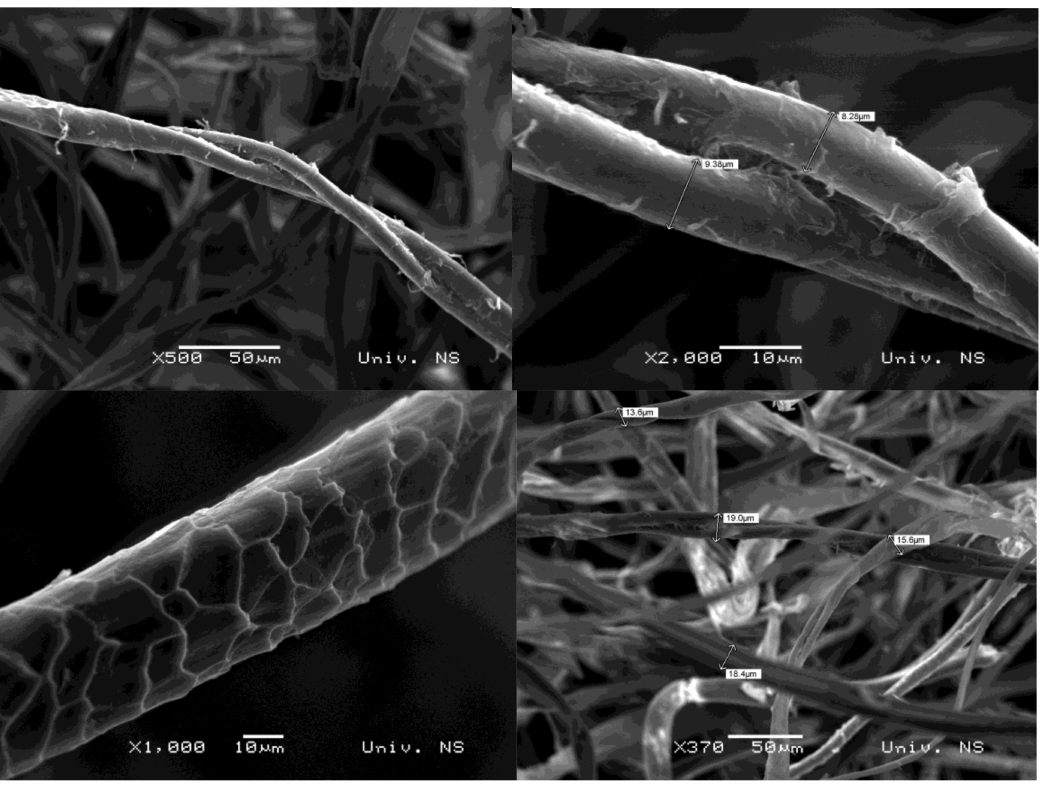
Figure 2. SEM microscopic images of textile